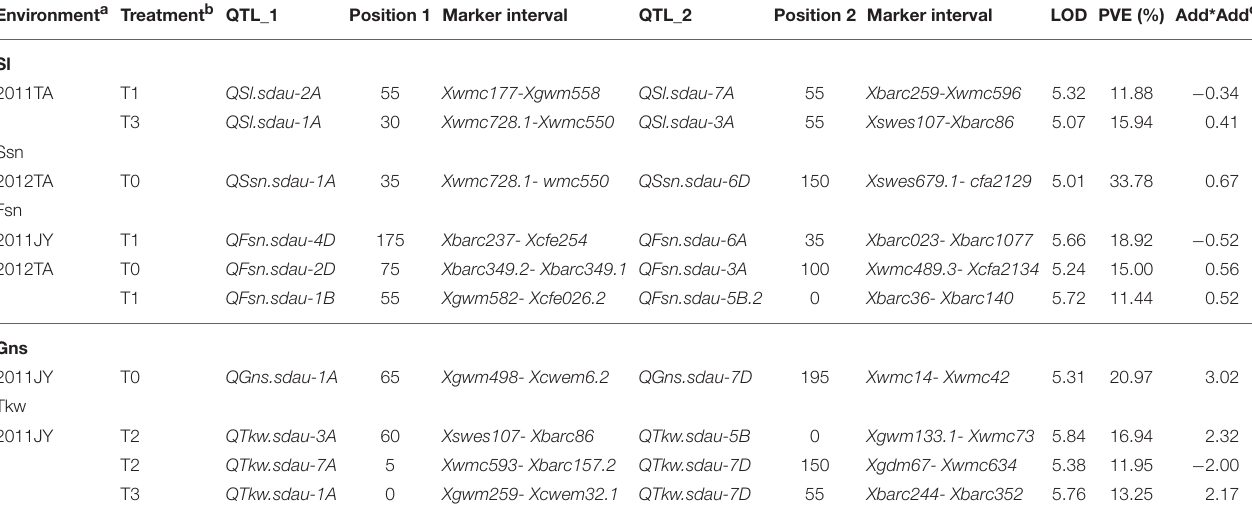
TABLE 9 | Epistatic QTLs identified for spike-related traits under different nitrogen supply dates in different years. Environment a Treatment b